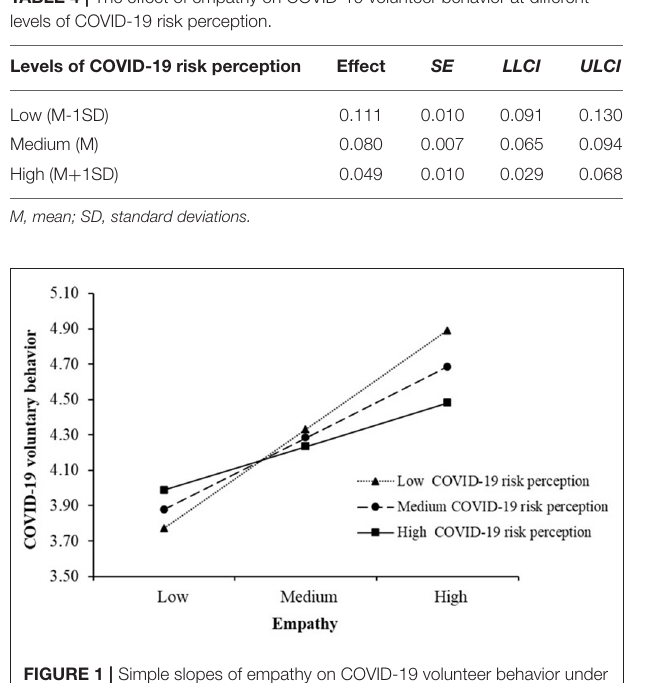
effect of empathy and COVID-19 risk perception on COVID- 19 volunteer behavior was significant ( β = − 0.005, p <